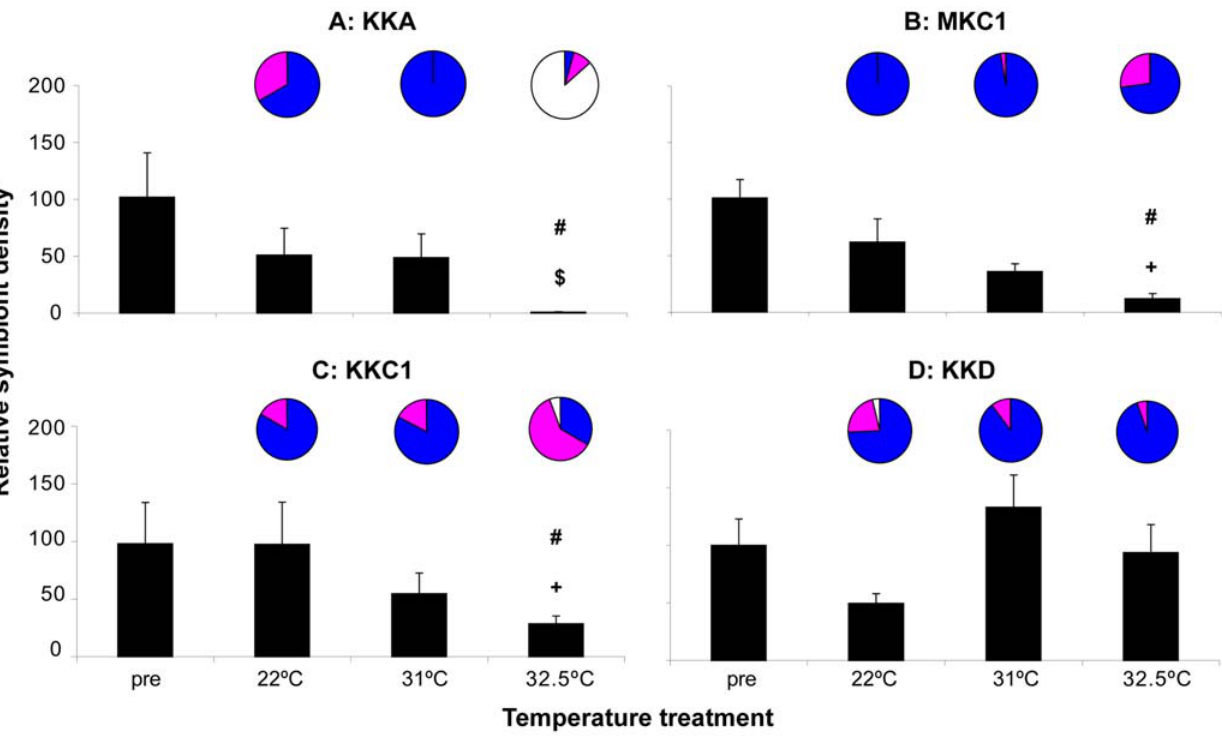
Figure 5. Heat-stress experiment 2: relative algal symbiont densities and coral condition. End effect of three different temperature regimes on the relative algal symbiont densities (bars) and coral condition (pies) of three groups of juvenile coral outplanted to Magnetic Island, and one outplanted to Magnetic Island. Blue=healthy, purple=pale, white=bleached. # =significantly different from lower temperatures within the same group (p , 0.05), $=significantly different from KKC1/MKC1 and KKD corals at the same temperature (p , 0.05), + =significantly different from KKA and KKD corals at same temperature (p , 0.05). KKA corals showed the strongest bleaching response as indicated by the strongest reduction in relative algal symbiont densities and bleached appearances, KKC1/MKC1 corals showed an intermediate bleaching response as indicated